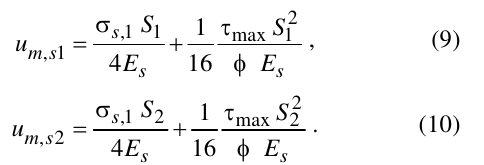
Table 2. Material properties used in application